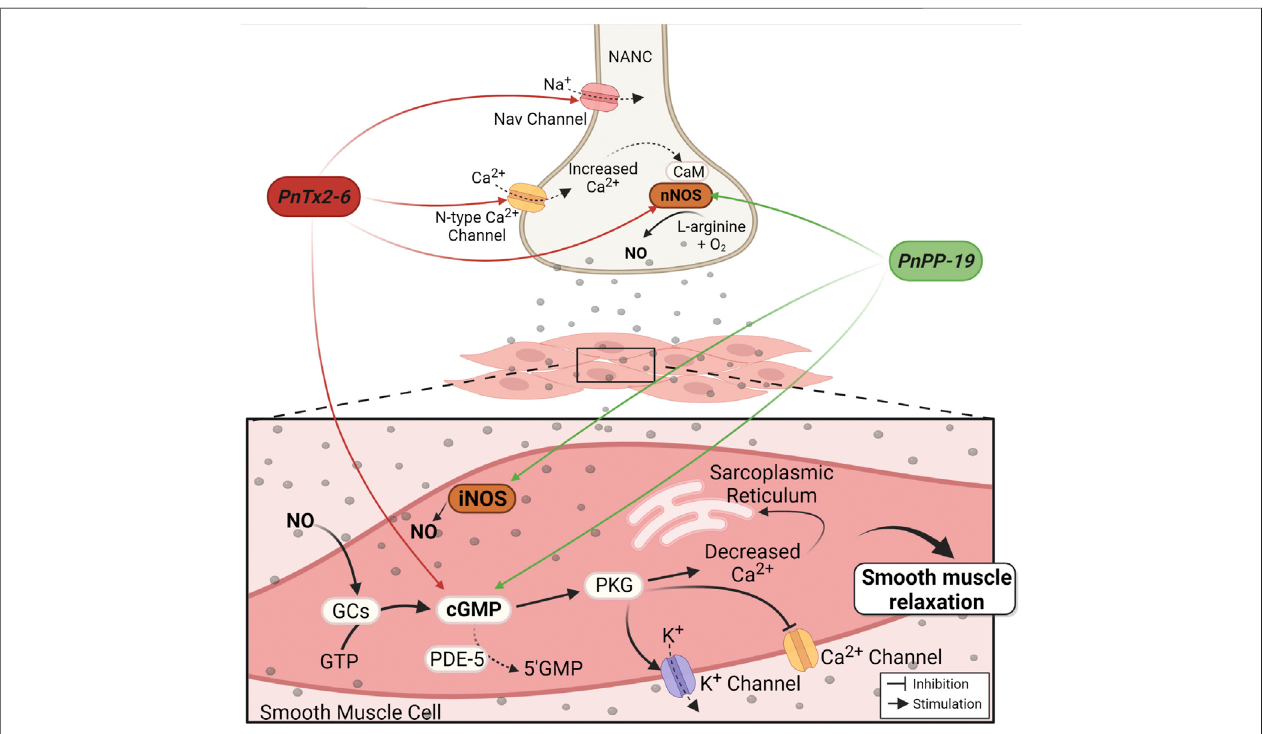
FIGURE2| MechanismofPnTx2-6toxinandPnPP-19peptideinthecorpuscavernosum.RedarrowsindicatePnTx2-6actionsandgreenarrowsindicatePnPP- 19actions.TheneuronaldepolarizationcausedbyPnTx2-6(bydelayNa + channelinactivationcurrent)leadstotheopeningofN-typeCa 2+ channels,increasingitsin fl ux. Increasein intracellular Ca 2+ triggersthe NOproduction and availability. NO production stimulates guanylate cyclase enzyme (GCs),rising cGMP,which stimulatesPKG resultinginblockadeofCavschannelsandopeningofKvschannels.TheaftermathisdecreasedCa 2+ insidethesmoothmusclecellleadingtorelaxationandpenile erection. Also, PnTx2-6 does not inhibit the action of the enzyme PDE-5. PnPP-19 (green arrows) increases NO and cGMP via nNOS and iNOS activation. PnPP-19 promotes CC relaxation without acting on voltage-dependent Na + channels, neither N-type Ca 2+ channels, and as PnTx2-6 it does not inhibit the action of PDE-5